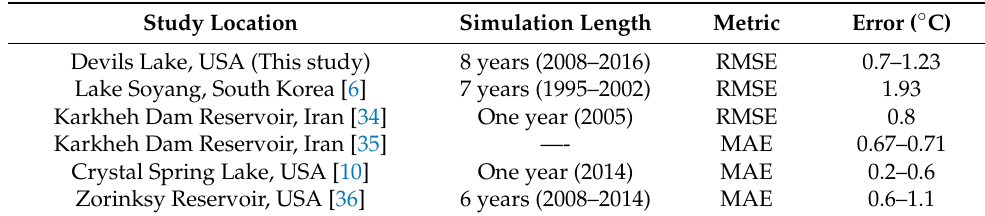
Table 3. Performance comparison of CE-QUAL-W2 simulation of water temperature between this study and previous studies. Study Location Simulation